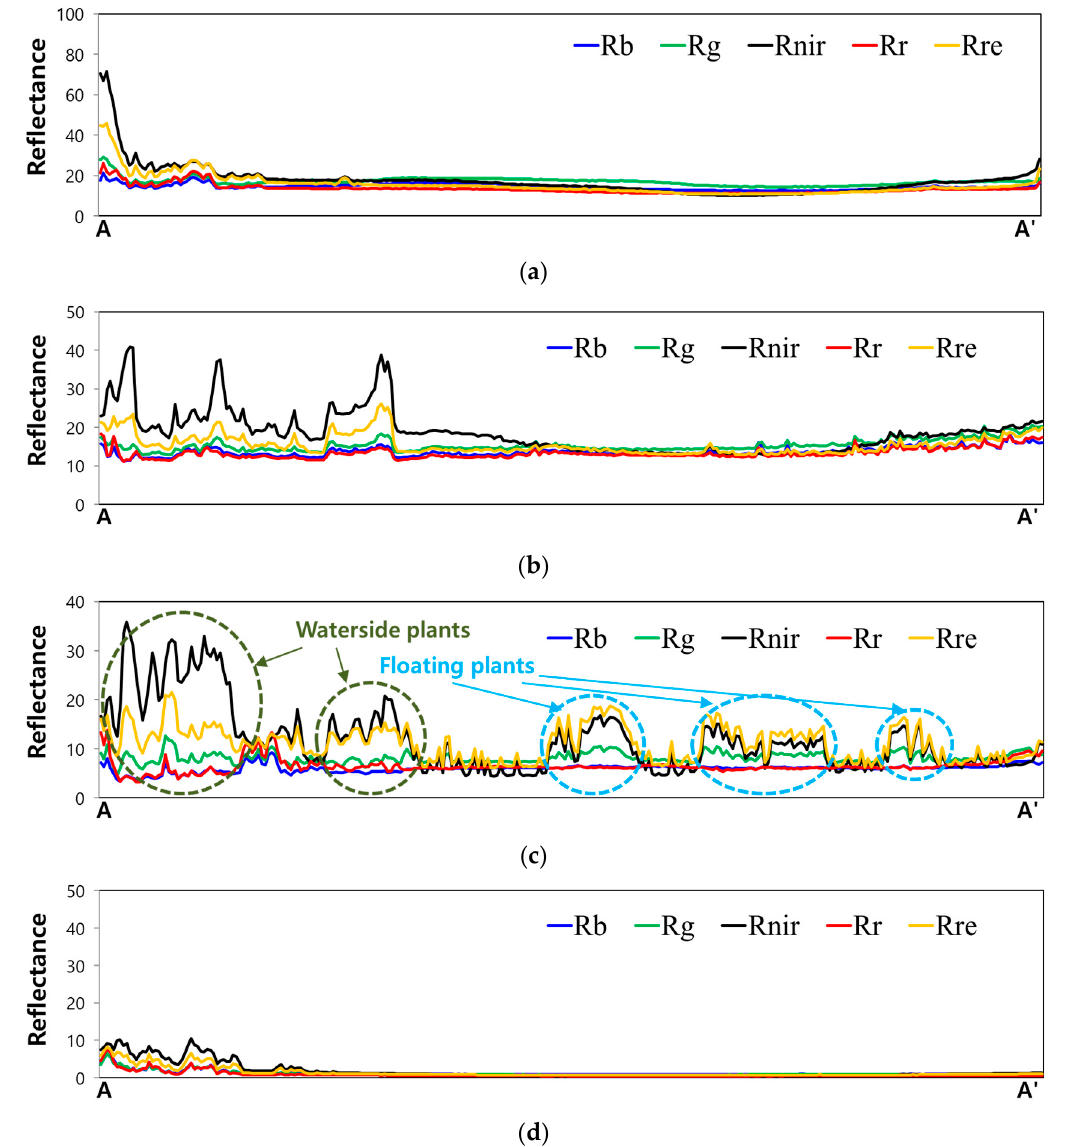
Figure 5. Profile analysis results for each spectral wavelength band. ( a ) 04/25/2018; ( b ) 05/20/2018; ( c ) 06/25/2018; ( d ) 10/24/2018.